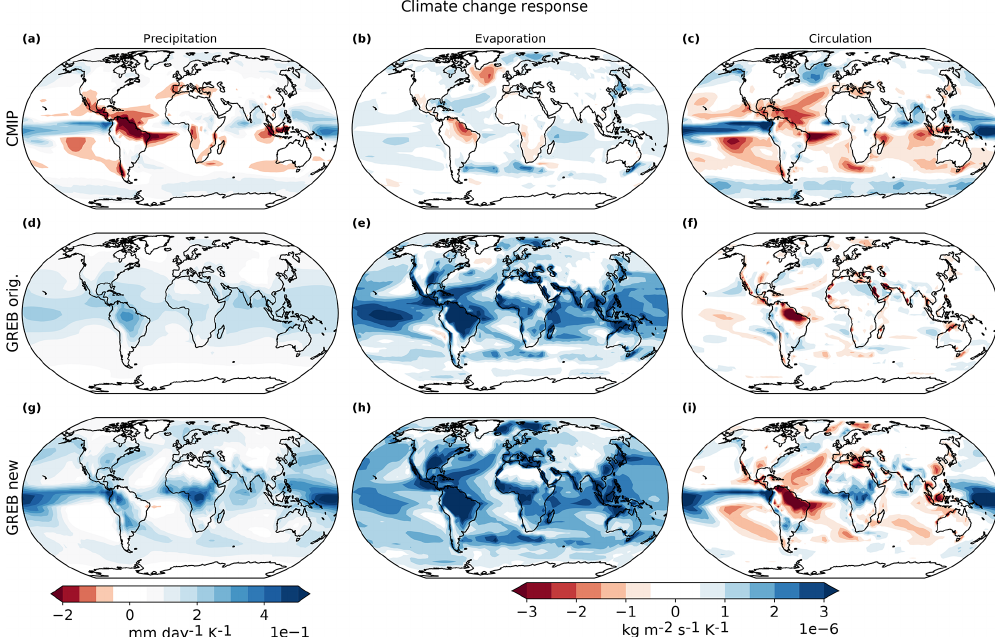
Figure 11. Response of the hydrological cycle to an RCP8.5 forcing in the CMIP5 ensemble mean for precipitation (a) in mmday − 1 , evaporation (b) and circulation (c) in kgm − 2 s − 1 , original GREB model for precipitation (d) , evaporation (e) and circulation (f) and the improved GREB model for precipitation (g) , evaporation (h) and circulation (i) . GREB uses prescribed anomalies from the CMIP5 ensemble mean of surface temperature, horizontal winds and vertical winds ( ω ). All responses are shown per degree of warming.